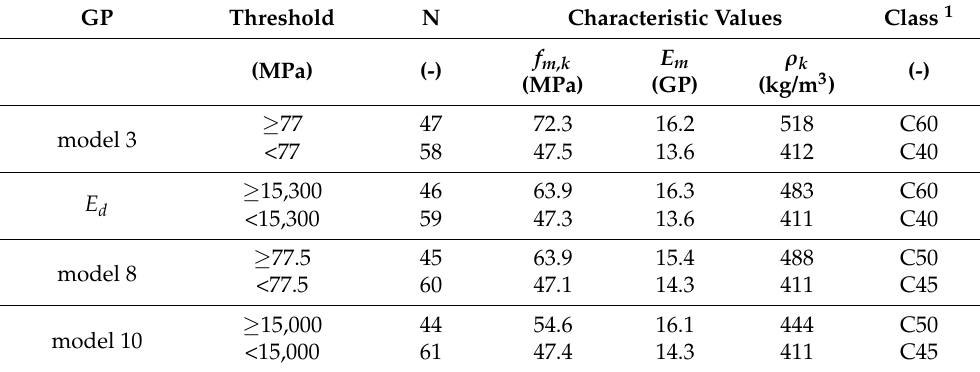
Table 7. Description of the two new grades divided by the threshold of the several grading parameters (GP). E d = dynamic modulus of elasticity; N = number of poles in the grade; f m,k = 5th percentile of bending strength; E m = mean modulus of elasticity; ρ k = 5th percentile of density.